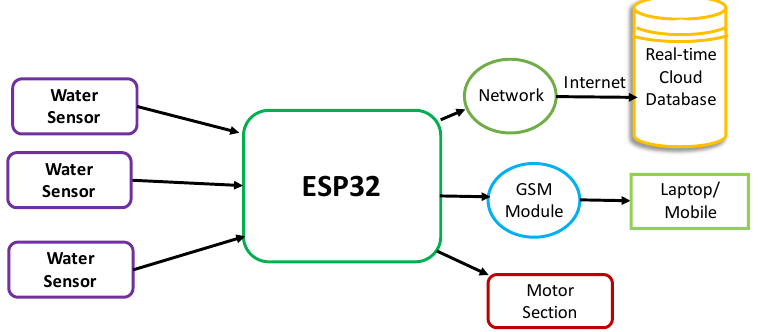
Figure 4. System diagram of the proposed system.